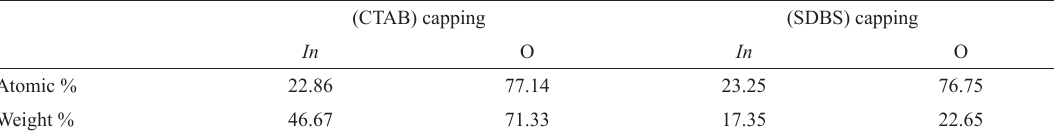
Figure 3: EDAX and SEM images of In Table 2: EDAX data of In